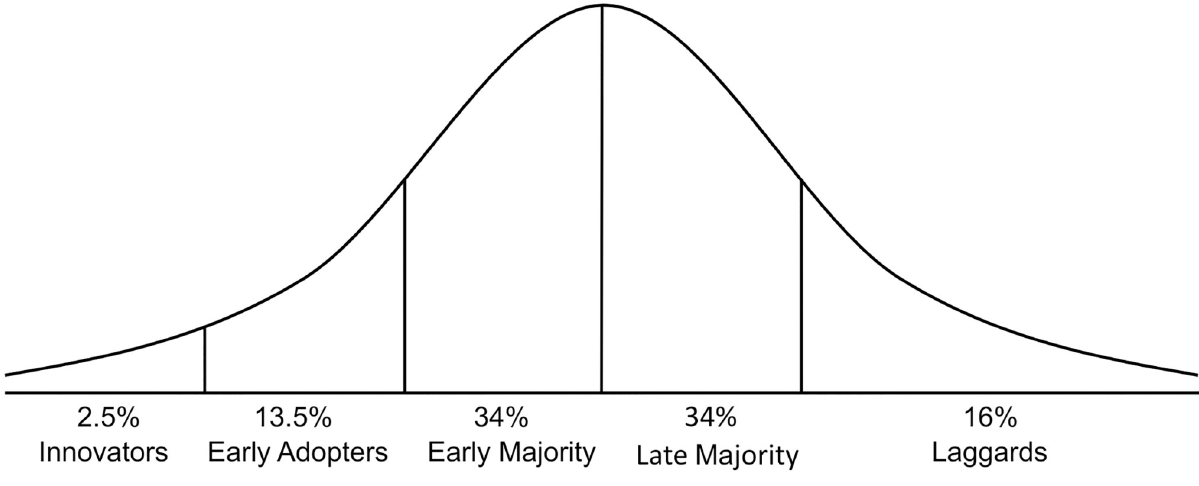
Fig 1. Diffusion of innovation model from Rogers